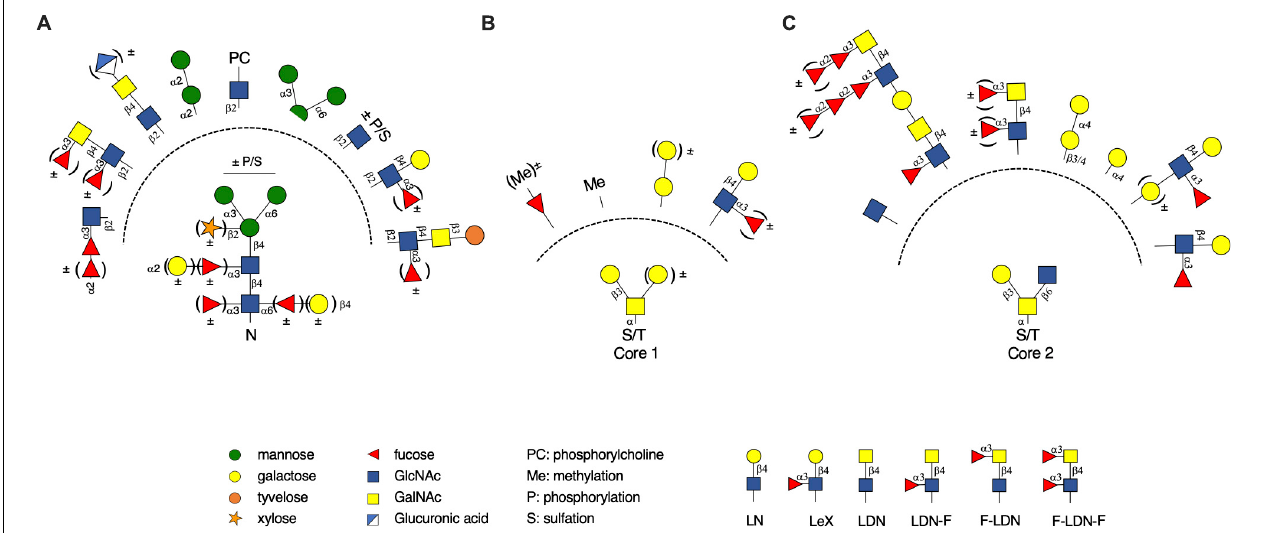
FIGURE 2 | Diversity of helminth glycans. (A) A selection of N- glycan motifs found on different helminth glycoproteins. Besides immature mannosidic glycans, helminth N- glycans can be substituted with different core residues or are extended with different glycan motifs in their antenna. Some modifications are shared with animals, whereas other modifications are quite unusual. (B,C) A selection of O- glycan motifs found on different helminth glycoproteins, which are divided between typical core 1 (B) and core 2 (C) O- glycans. The linkage between different monosaccharides has been indicated where